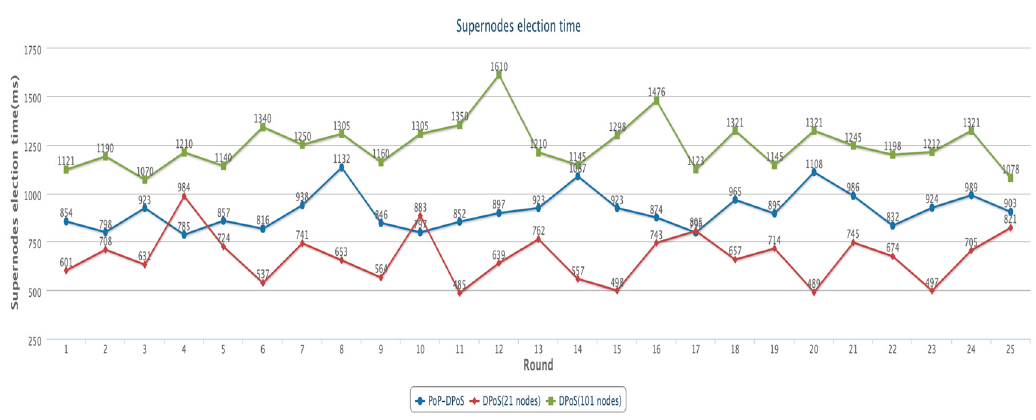
Figure 7. Supernodes election time .